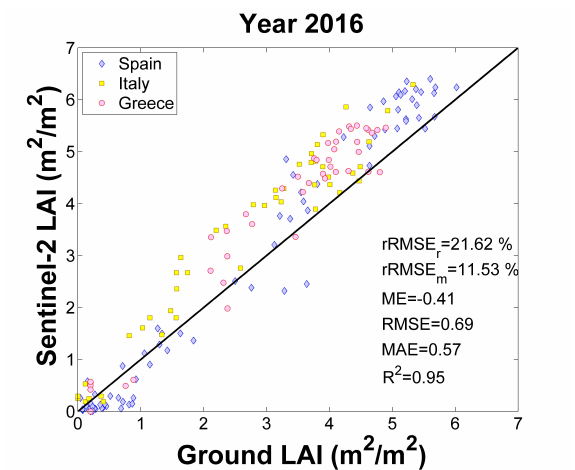
Figure 4. Scatter plots of Sentinel-2A estimated LAI values versus in situ LAI measurements during the 2016 rice season. For the sake of visualization, the standard deviation of measurements and Sentinel-2A prediction uncertainty ( ≈± 0.8) are not shown. Table 2. Statistical indicators (coefficient of determination (R 2 ), root mean squared error